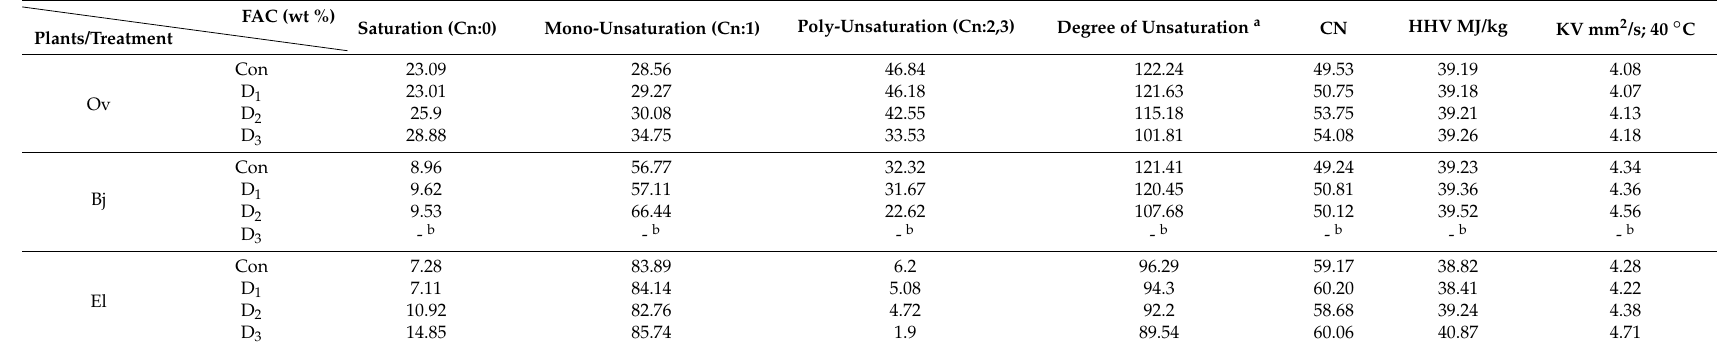
Table A2. Effect of different levels (Con: 25% moisture, D 1 : 17% moisture, D 2 : 14% moisture, and D 3 : 11% moisture) of drought stress on the fatty acid composition and fuel properties of the oil samples from the three plant species.